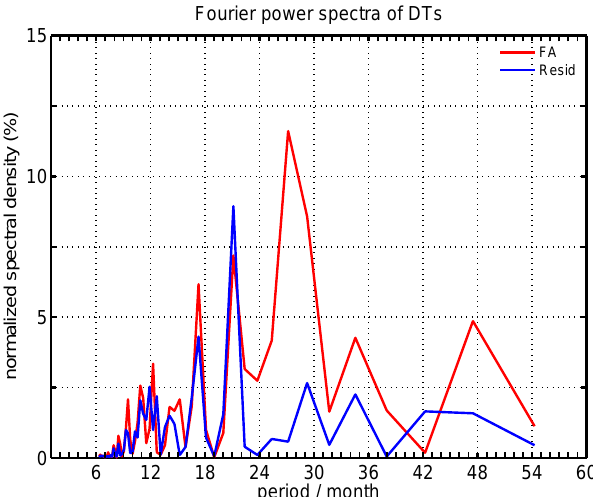
Fig. A2. Fourier power spectra of the detrended time series anoma- lies of fraction of area covered with DTs, FA. The blue curve shows Fig. 16. Fourier power spectra of the detrended time series anomalies of fraction of area covered with DTs, FA . The blue curve shows the spectra of the residual time series, i.e. the water vapour time series after the the spectra of the residual time series, i.e., the FA time series after QBO,ENSOandsolarcyclesignalshavebeenremovedbyamultilinearregression. the QBO, ENSO and solar cycle signals have been removed by a multilinear regression.